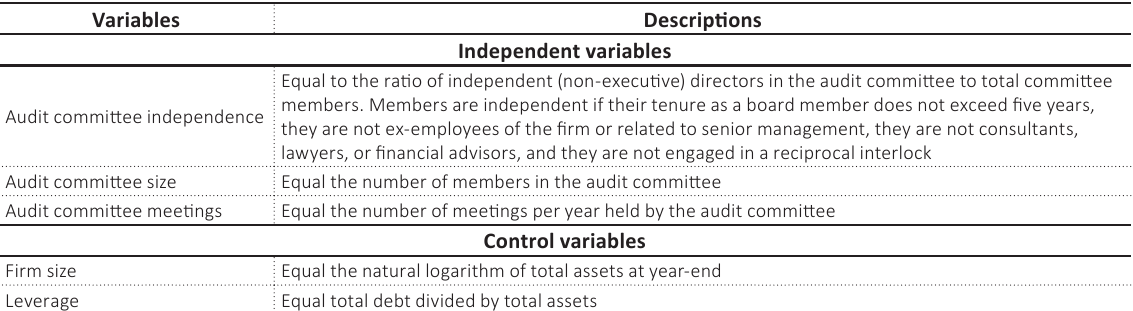
Table 2. Descriptions of explanatory and control